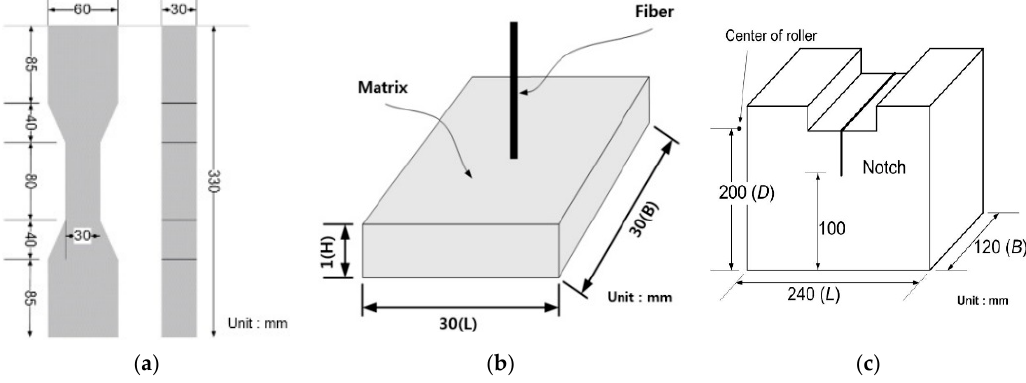
Figure 1. Specimen for ( a ) uniaxial tension test; ( b ) single fiber pullout test; and ( c ) matrix fracture test.